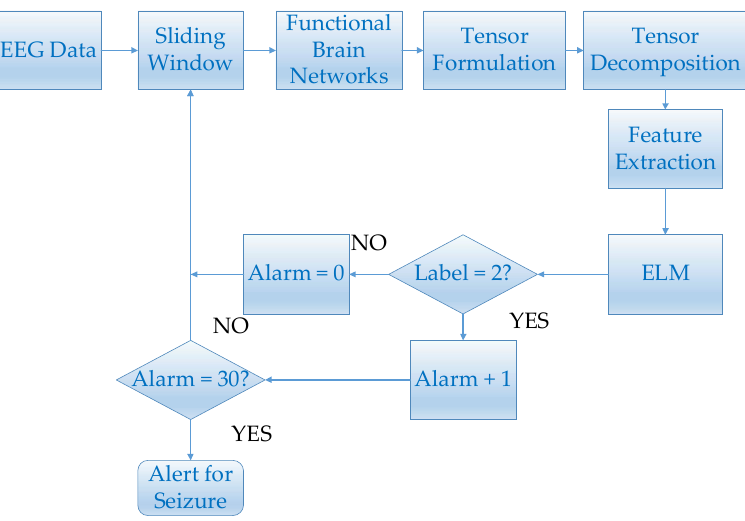
Figure 5. This figure shows the flowchart of epilepsy prediction.